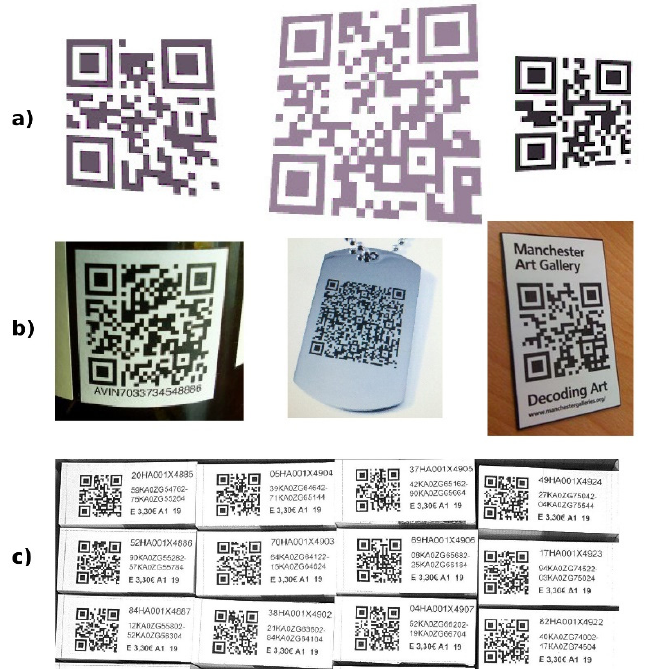
Figure 20. Testing samples: ( a ) synthetic; ( b ) Internet; ( c ) manufacturing.